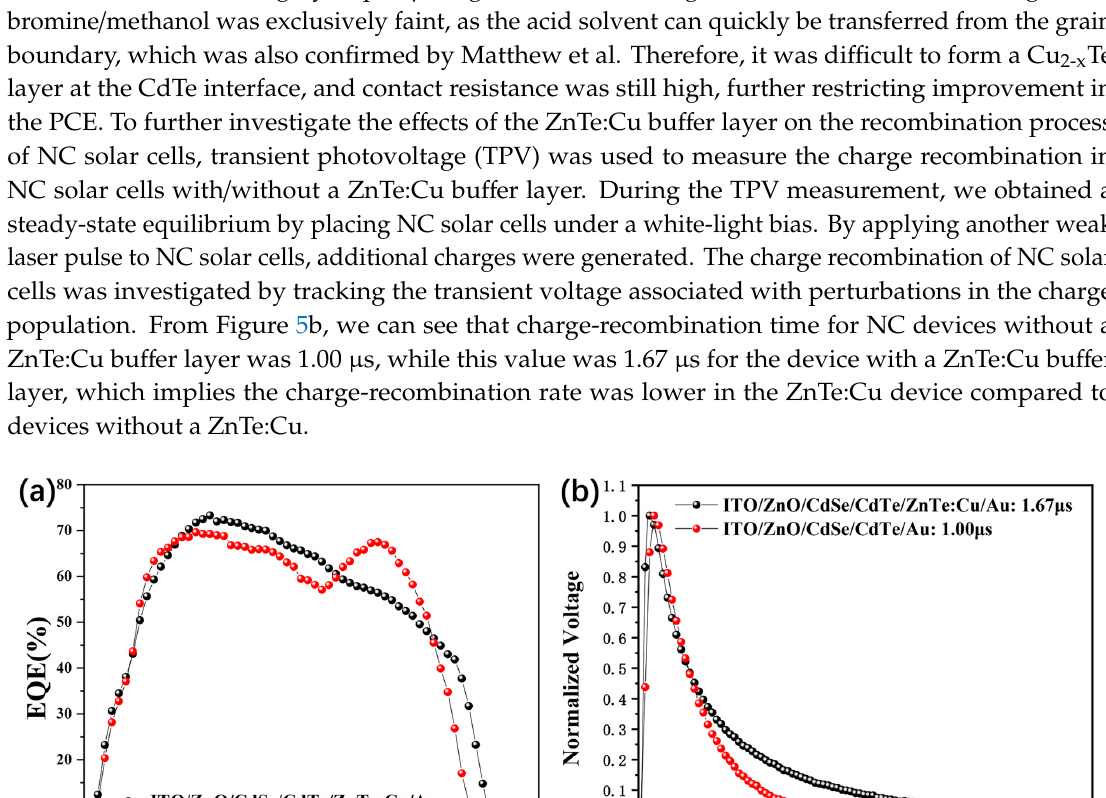
Figure S1: (a) J–V characteristic of NC solar cells with di ff erent thickness of Cu film (all devices annealing at 200 ◦ C); (b) J–V characteristic of NC solar cells with di ff erent annealing temperature (all devices with 2.1 nm Cu film), Figure S2: (a) J–V characteristic of NC solar cells of ITO / ZnO / CdSe / CdTe / ZnTe / Cu (1 nm) / Au structure with di ff erent thickness of ZnTe film (all devices annealing at 200 ◦ C); (b) J–V characteristic of NC solar cells with di ff erent annealing temperature (all devices with 20 nm ZnTe film and 1 nm Cu film), Table S1: Summary of the photovoltaic parameters of the NC solar cells prepared under di ff erent conditions from Figure